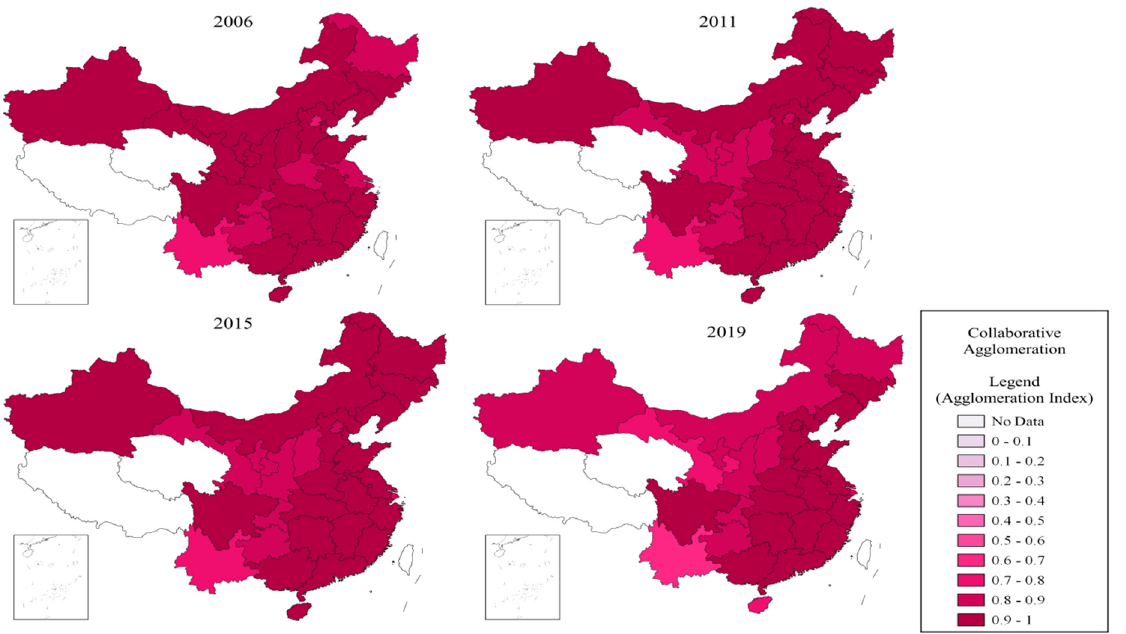
Figure 10. Distribution of collaborative agglomeration in different provinces of China from 2006 to 2019. (Note: Figures 8–10 are plotted by the authors using the open-source software QGIS, which is permitted for free academic use under its protocol of usage; the data contained in the maps are public data from the Statistical Yearbook of Chinese Provinces. ).